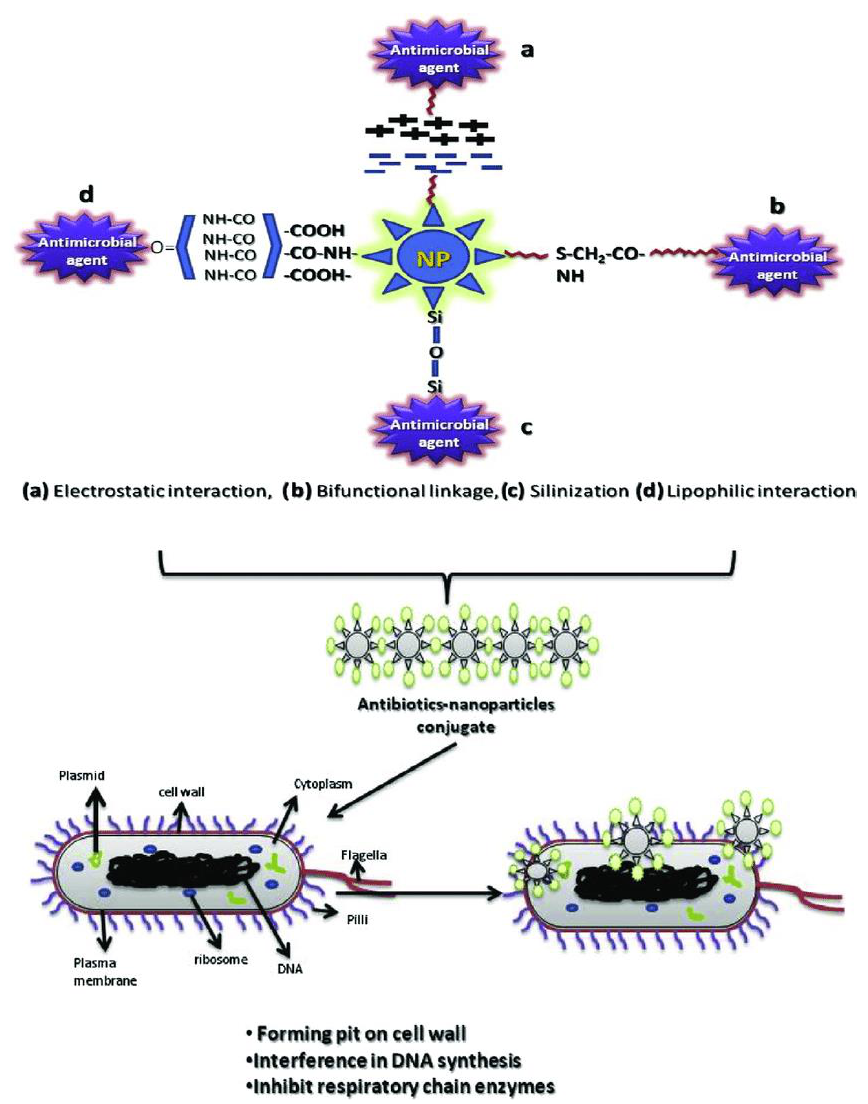
Figure 4. Antibiotic conjugation with nanoparticles.